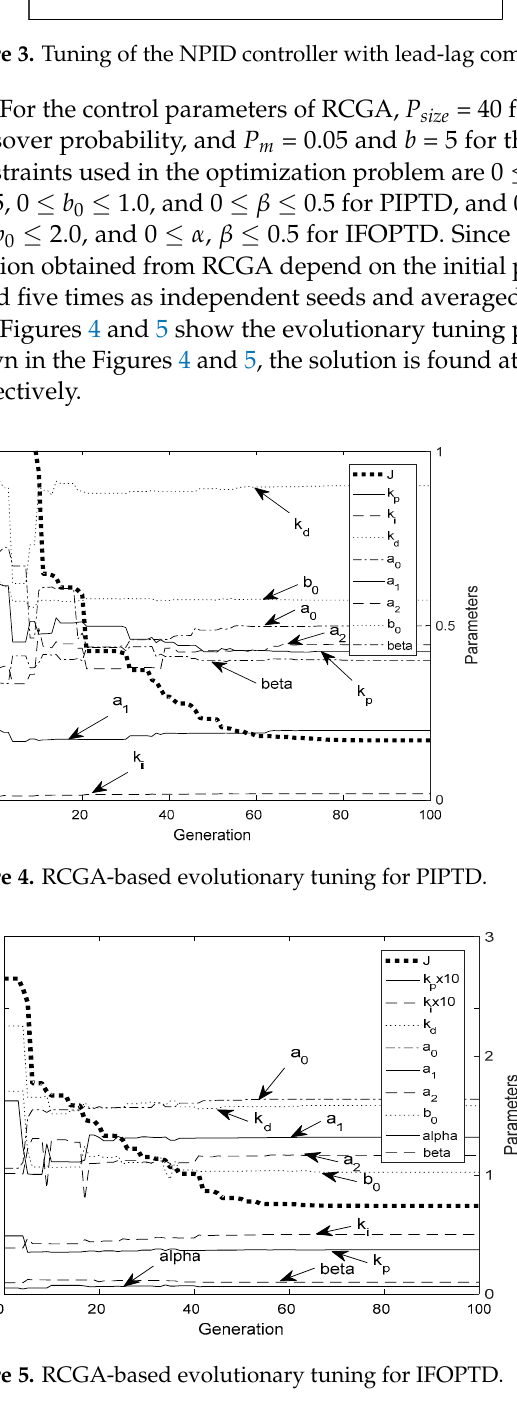
Table 1. Controller tuning for PIPTD.